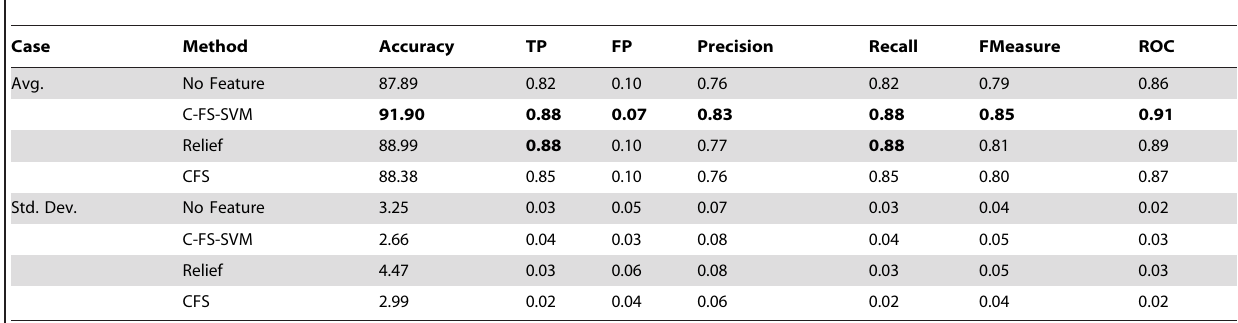
Table 2. Standard Deviations of classification results for external cross validation with SMO and their average performance results for each